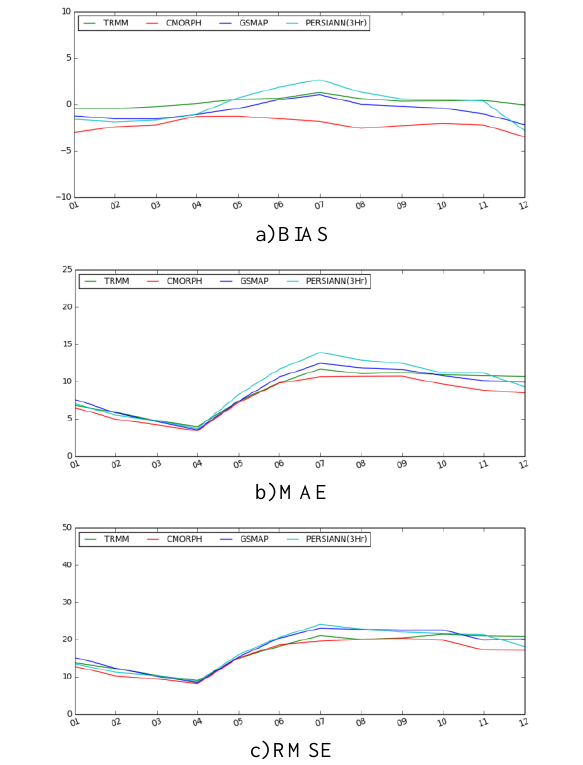
Figure 3. (a) Bias, (b) MAE and (c) RMSE of all station for each satellite precipitation dataset Active convection on the western coast of the Philippines is prevalent during the southwest monsoon season. On the other hand, precipitation on the eastern coast is produced from the interaction of northeasterly and/or trade winds with local topography during the northeast monsoon season. Ten (10) stations (SYNOP station: Laoag, Baguio, Cabanatuan, Dagupan, Subic, Clark, Manila, NAIA, Science Garden, San Jose, Iba and Vigan) located to the west and eleven (11) stations (SYNOP station: Appari, Virac, Legazpi, Guian, Catarman, Infanta, Daet, Borongan, Surigao, Hinatuan, Dipolog) on the eastern coast of the Philippines were chosen to represent the different rainfall regimes of the archipelago. Figure 4 (a) and (b) show MAE and RMSE, respectively, from observations located on the western coast. While figure 5 (a-b) are for stations from the east coast. All datasets generally follow the same trend. As expected, higher error is found during the peak rainy season of both